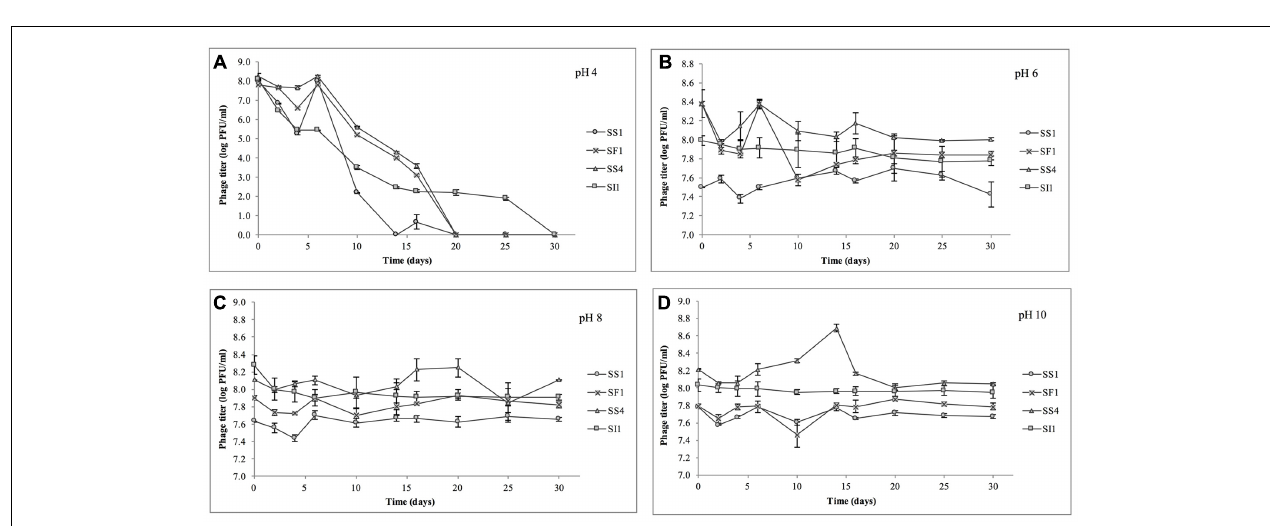
FIGURE 4 | Stability of phages SI1, SF1, SS1, and SS4 at (A) pH 4, (B) pH 6, (C) pH 8, and (D) pH 10 over a period of 30 days. Data shown are the mean of three replicates ±